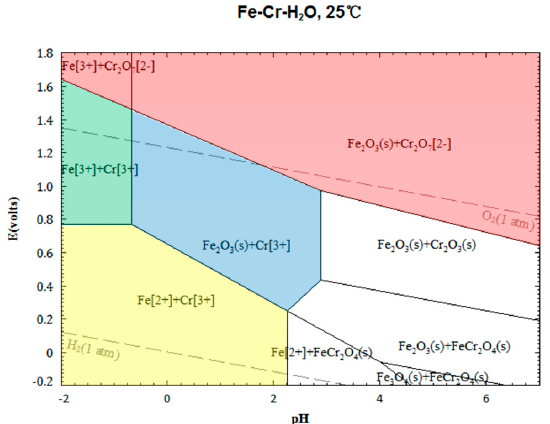
Figure 2. E-pH diagram of the Cr-Fe-H 2 O system.